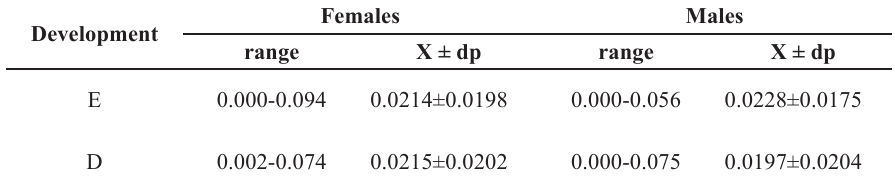
Fig 8 . Discriminant Analysis based on four wing linear measurements Fig 9 . Canonical Variate Analysis (CVA) showing morphometric (see Table 4) and body mass of males (grey) and females (orange) of dimorphism between males (grey) and females (orange) of P . Podium denticulatum . denticulatum Table 5 . Wing comparison (difference in mm between the right and left wing width) from females and males adults of P. denticulatum that entered (E) or not entered (N) diapause during the development.